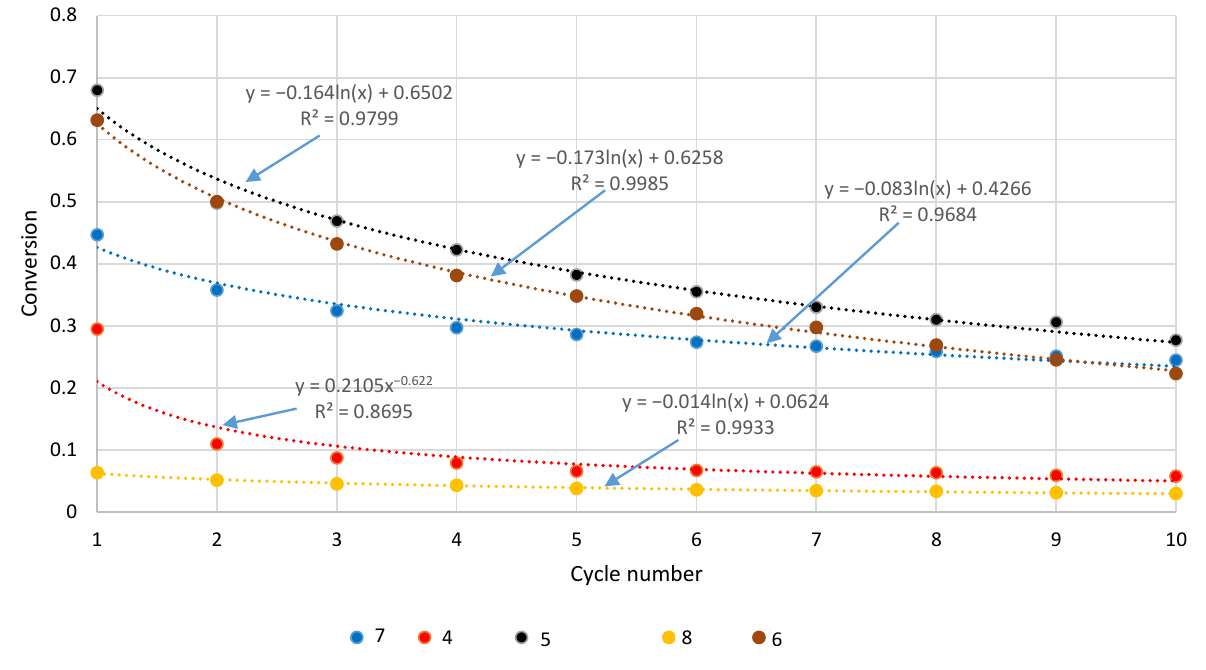
Figure 17. The conversion of magnesite and non-carbonate rocks in the CaL process.